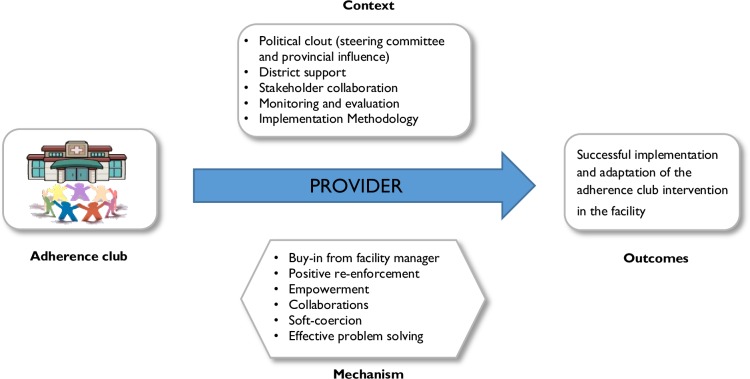
CMO for providers.